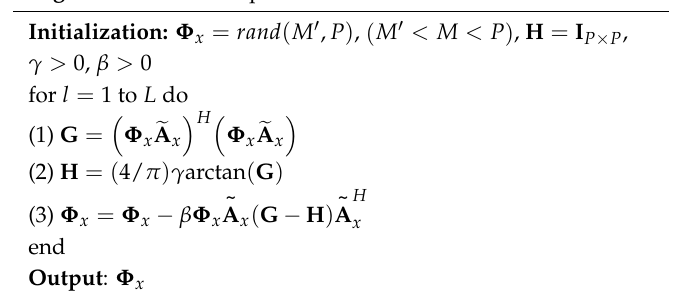
Algorithm 2. Matrix